Question: According to the figure, is the described quantity increasing or decreasing?
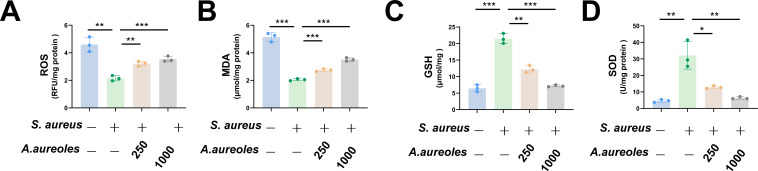
Answer: increasing